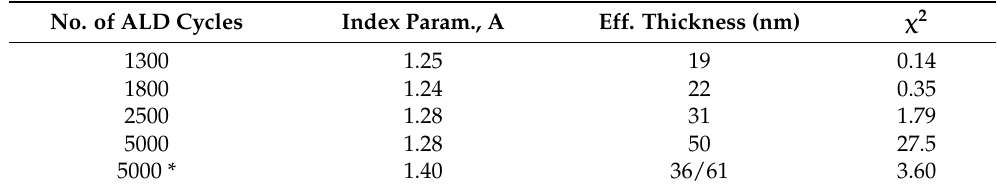
Table 1. The results of ellipsometric and reflectance fitting over the wavelength range of 190–885 nm for LiF films deposited with an increasing number of ALD cycles and fit to a single parameter Cauchy model.